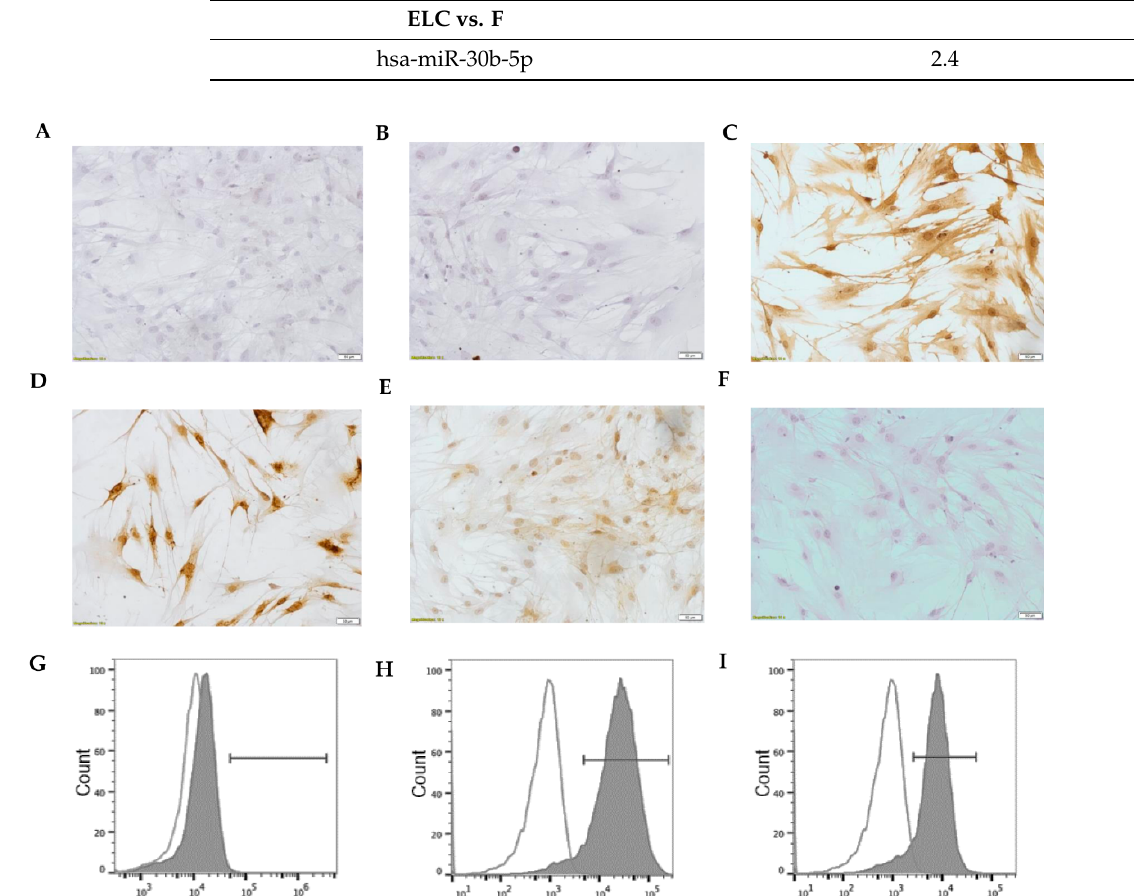
Figure 9. Similar fibroblasts to those converted in ELC showed characteristic biomarkers of fibroblast phenotype but not pancytokeratin. Normal lung fibroblasts (passage = 4; n = 3) were grown and seeded on coverslips, fixed, and labeled with antibodies for immunocytochemistry before being analyzed by cytofluorometry. Pancytokeratin ( A ), Thy-1 cell surface antigen ( B ), vimentin ( C ), type I collagen ( D ), PDGFR β ( E ), secondary anti IgG antimouse alone, used as a negative control ( F ). Cell fluorometric analysis confirmed the absence of pancytokeratin ( G ), and the presence of PDGFR β ( H ), and vimentin ( I ). Representative flow cytometry histograms showing the expression of pancytokeratin (negative) ( G ), PDGFR β (positive) ( H ), and vimentin (positive) ( H ). Unshaded histogram corresponds to the staining control with the secondary antibodies alone.